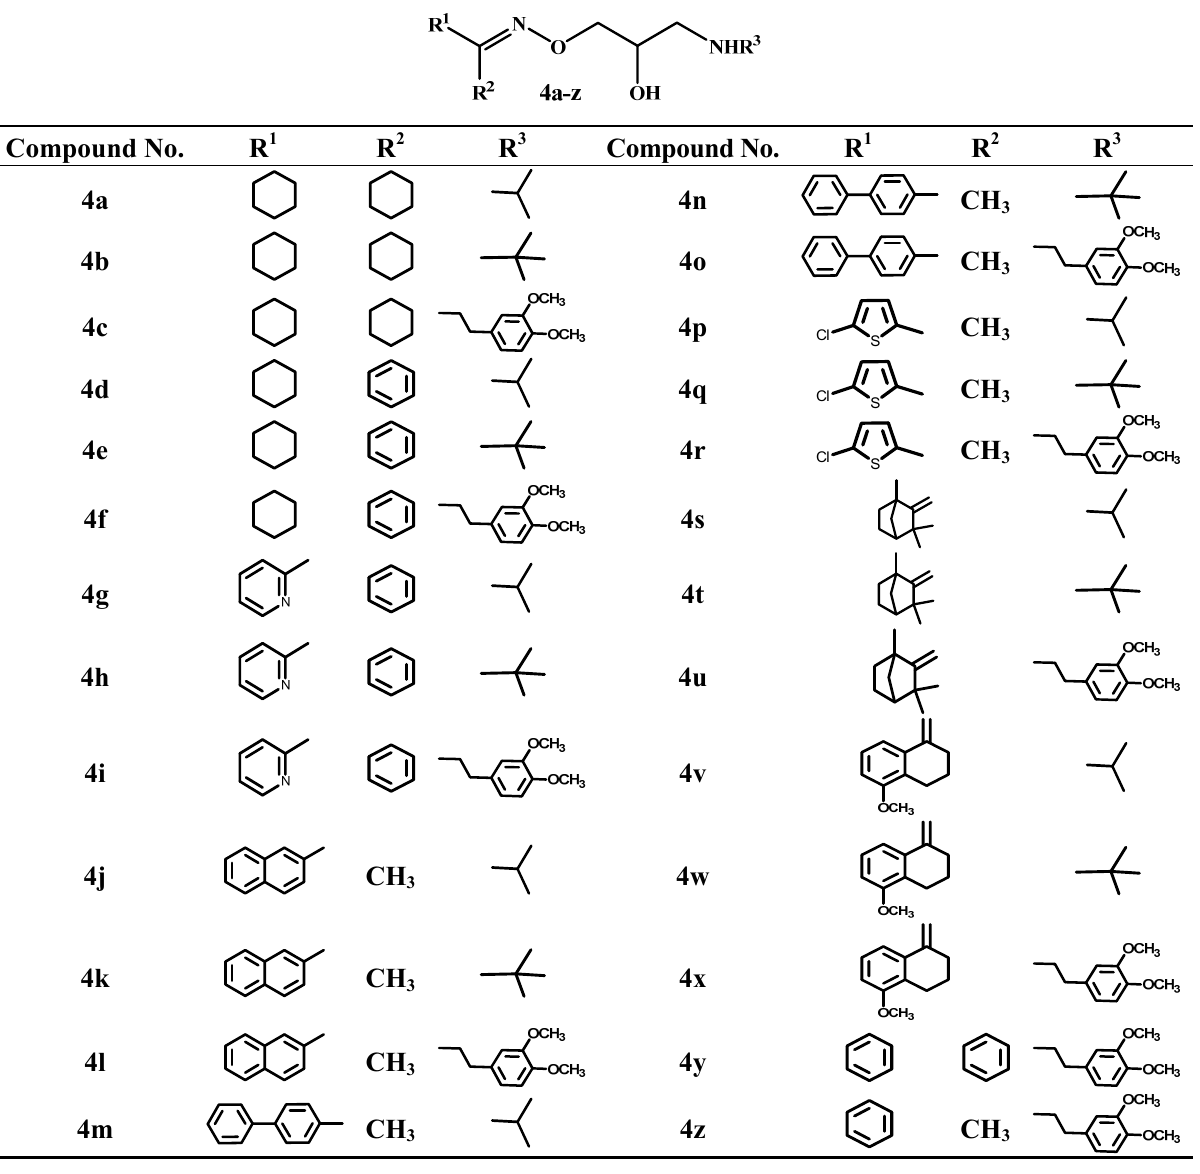
Table 2. O -(3-Alkylamino-2-hydroxypropyl)oxime derivatives 4a – z .